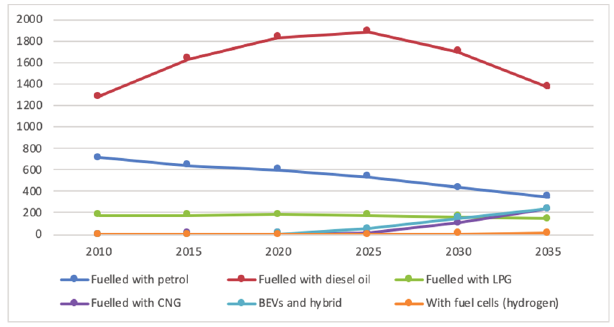
Fig. 2. Forecasts of number of vehicles other than passenger cars with GVM up to 3.5 tons by types of energy carriers in Poland up to year